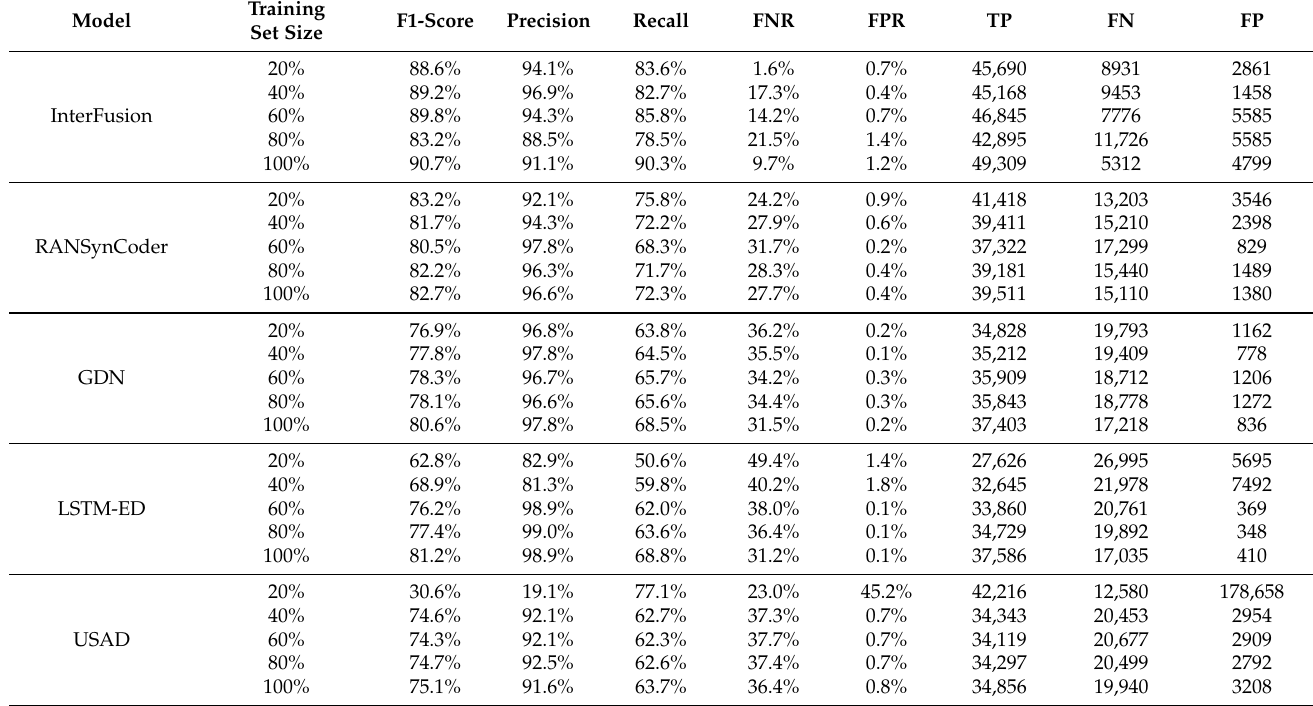
Table 8. Performance of anomaly detection models by varying the size of the training set in SWaT.